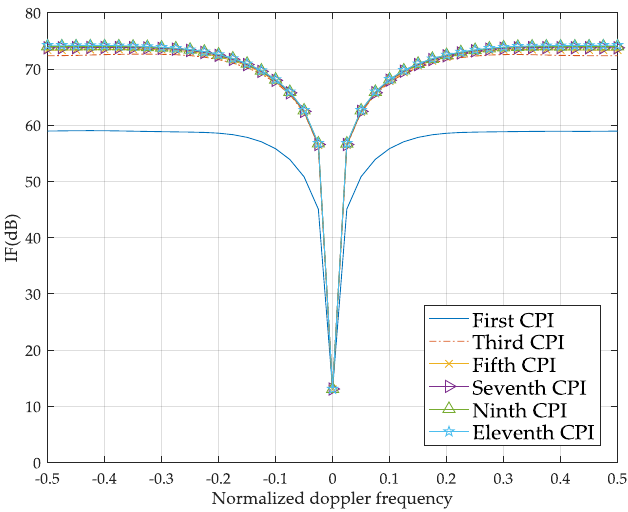
Figure 4. IF curves of the proposed and conventional methods. IF curves with respect to the normalized Doppler frequency, space transmit frequency, and space receive frequency are shown in ( a ), ( b ), and ( c ), respectively. In each figure, two other normalized frequencies are zero.